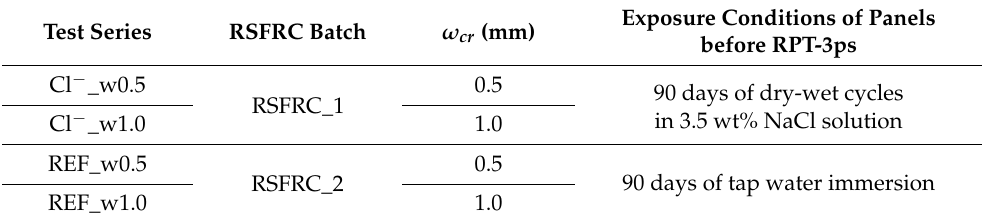
Table 2. The experimental program of